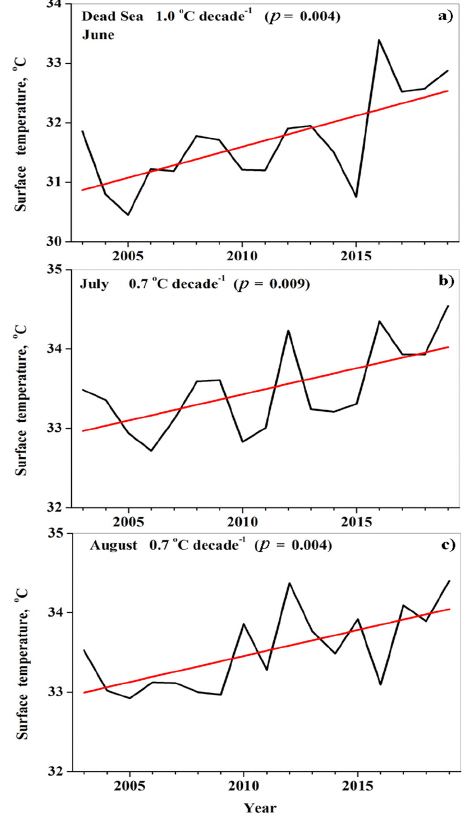
Figure 15. Year-to-year variations of satellite MODIS/Terra surface water temperature in the Dead Sea in ( a ) June, ( b ) July, and ( c ) August, during the period 2003–2019. The straight red lines designate linear